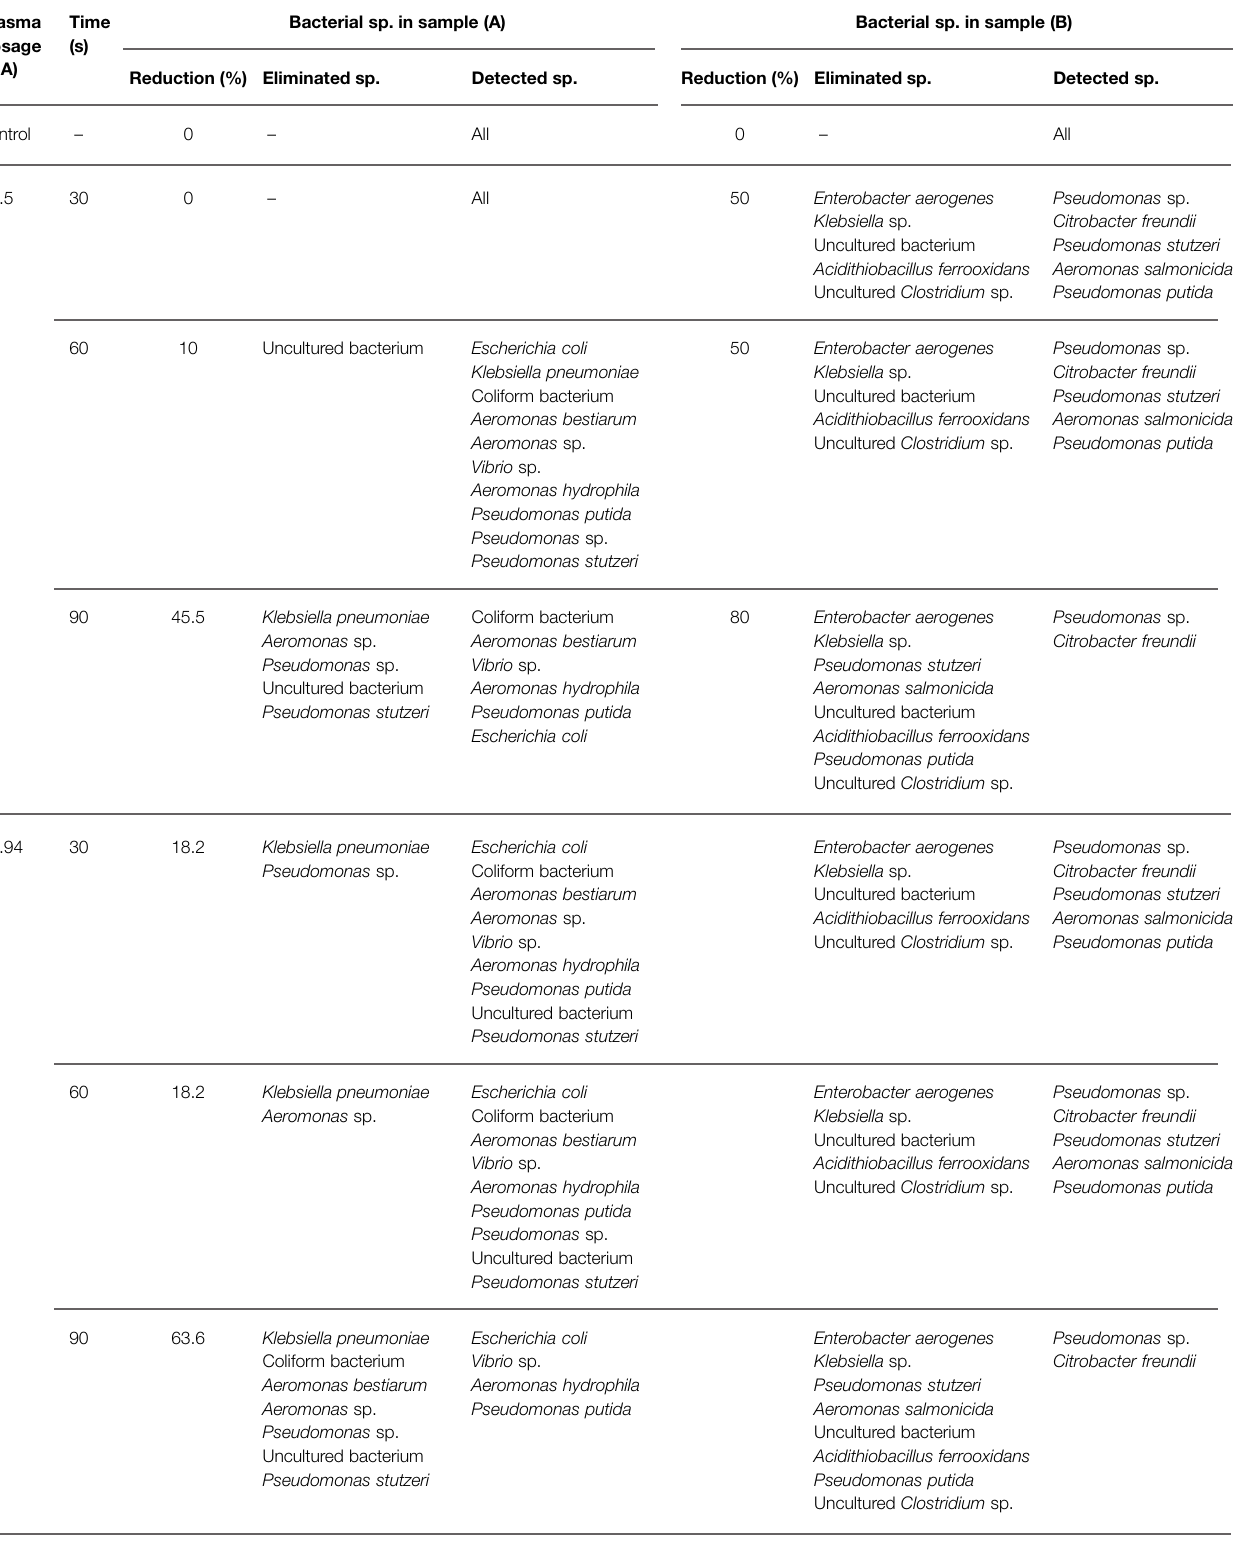
TABLE 2 | Dynamics of wastewater’s bacterial populations in response to different dielectric barrier discharge (DBD) plasma treatment protocols.